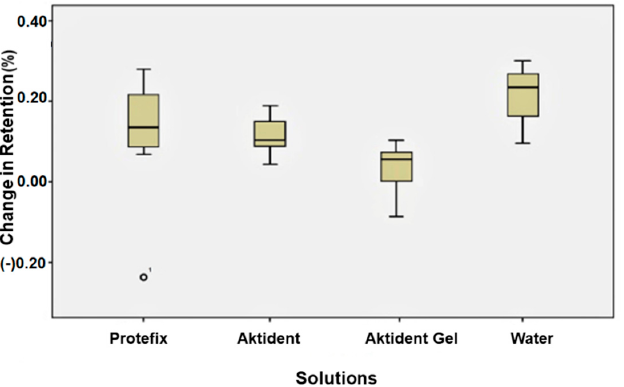
Figure 2. Retention values (N) before and after cleansing (Y: yellow, G: green, R: red, PAC: Protefix